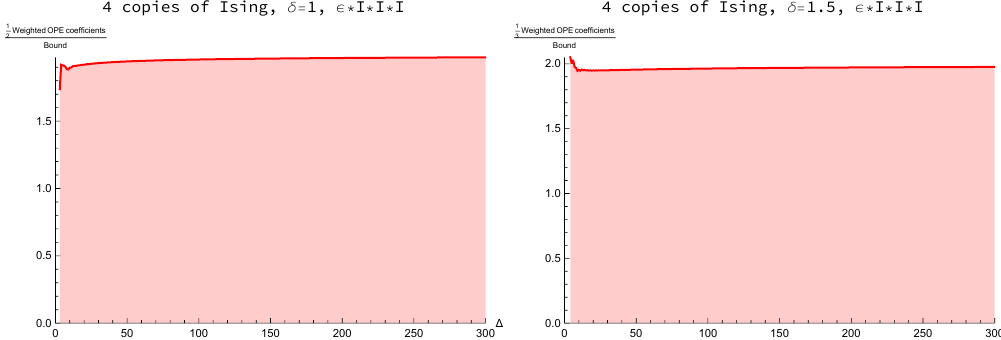
Figure 3 . Ratio of the weighted three point coe(cid:14)cient and the bound for 4 copies of Ising model with c e(cid:11) = 2, verifying the lower bound. The operator O = (cid:15) (cid:2) I (cid:2) I (cid:2) I . We have divided the weighted three point coe(cid:14)cients by the bin width 2 (cid:14) and we have taken the order one number appearing in the bound to be 0 : 5. Technically 0 : 5 can only be chosen for (cid:14) > 1 of (cid:14) , the order one number is less than 0 : 5. Nonetheless, if the bound is satis(cid:12)ed with 0 : 5, it will be so with any number less than 0 : 5.